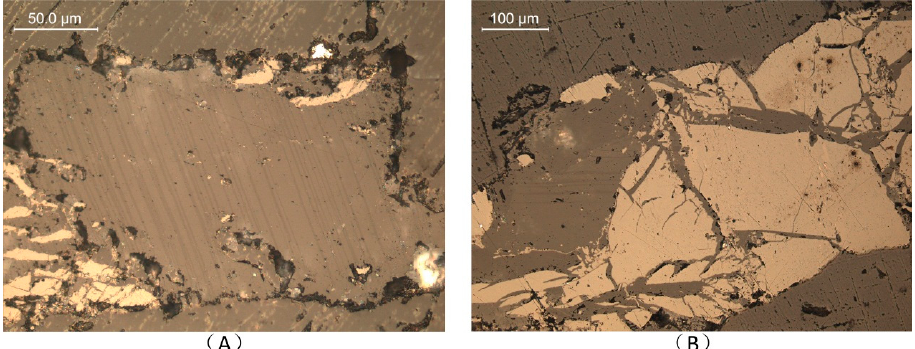
Figure 7. Calcite in C25-2. Optical microscope, reflected light. ( A ) Fracture-filling calcite and; ( B ) Fracture-filling calcite.